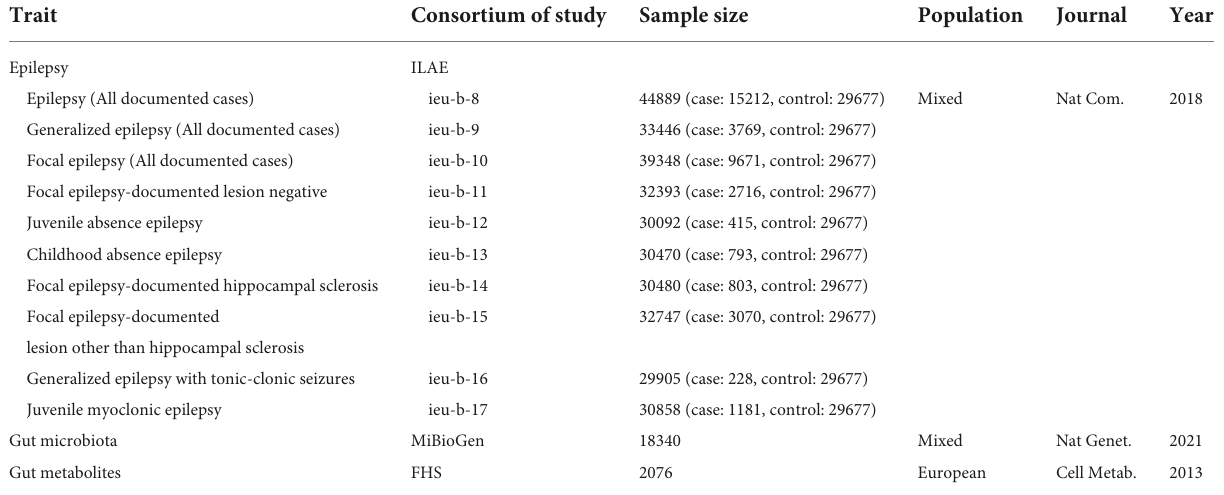
TABLE 1 Characteristics of included GWAS summary-level data of epilepsy, gut microbiota, and gut metabolites. Trait Consortium of study Sample